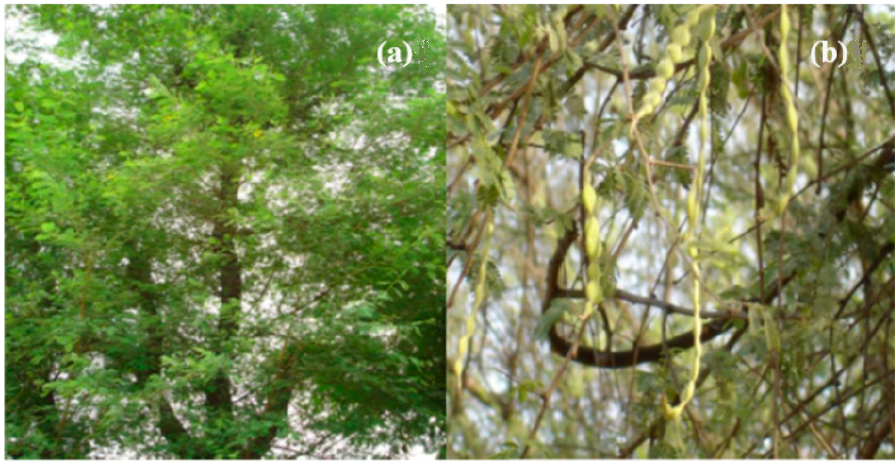
Figure 1. ( a ) Acacia nilotica tree, ( b ) fruits of Acacia nilotica.